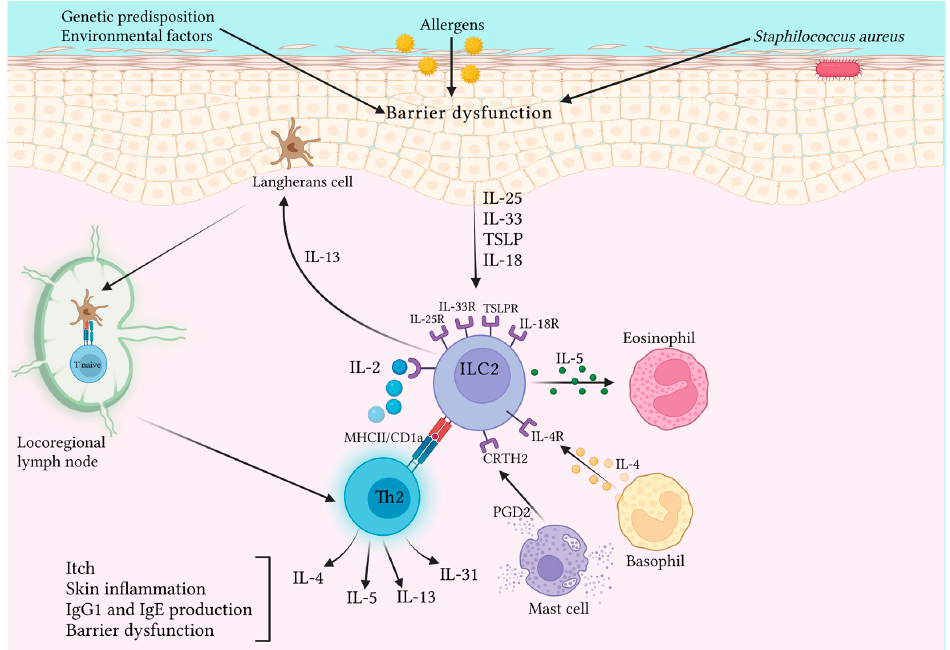
Figure 2. Following skin barrier alteration, damaged keratinocytes release epithelial-derived cytokines, including IL-25, IL-33, IL-18, and TSLP. ILC2s expressing the receptors for these cytokines (IL-25R, IL-33R, IL-18R, and STLP-R) on their surface are then activated, in turn, releasing Th2 cytokines. Among these, IL-5 determines the activation of eosinophils, while IL-13 stimulates epidermal Langerhans cells (LC), which in turn, migrate to regional lymph nodes to prime naïve T cells by antigen presentation via MHCII to promote the development of Th2 cells. Th2 cells produce IL-4, IL-5, IL-13, and IL-31. All these cytokines promote itch, skin inflammation, IgG1 and IgE production and maintenance of barrier dysfunction, thus rendering this condition chronic. Finally, ILC2s can act as antigen-presenting cells for Th2 effector cells through antigen presentation via MHCII and/or CD1a prompting them to produce IL-2, which in turn, sustains ILC2 activation and survival. Created with BioRender.com.